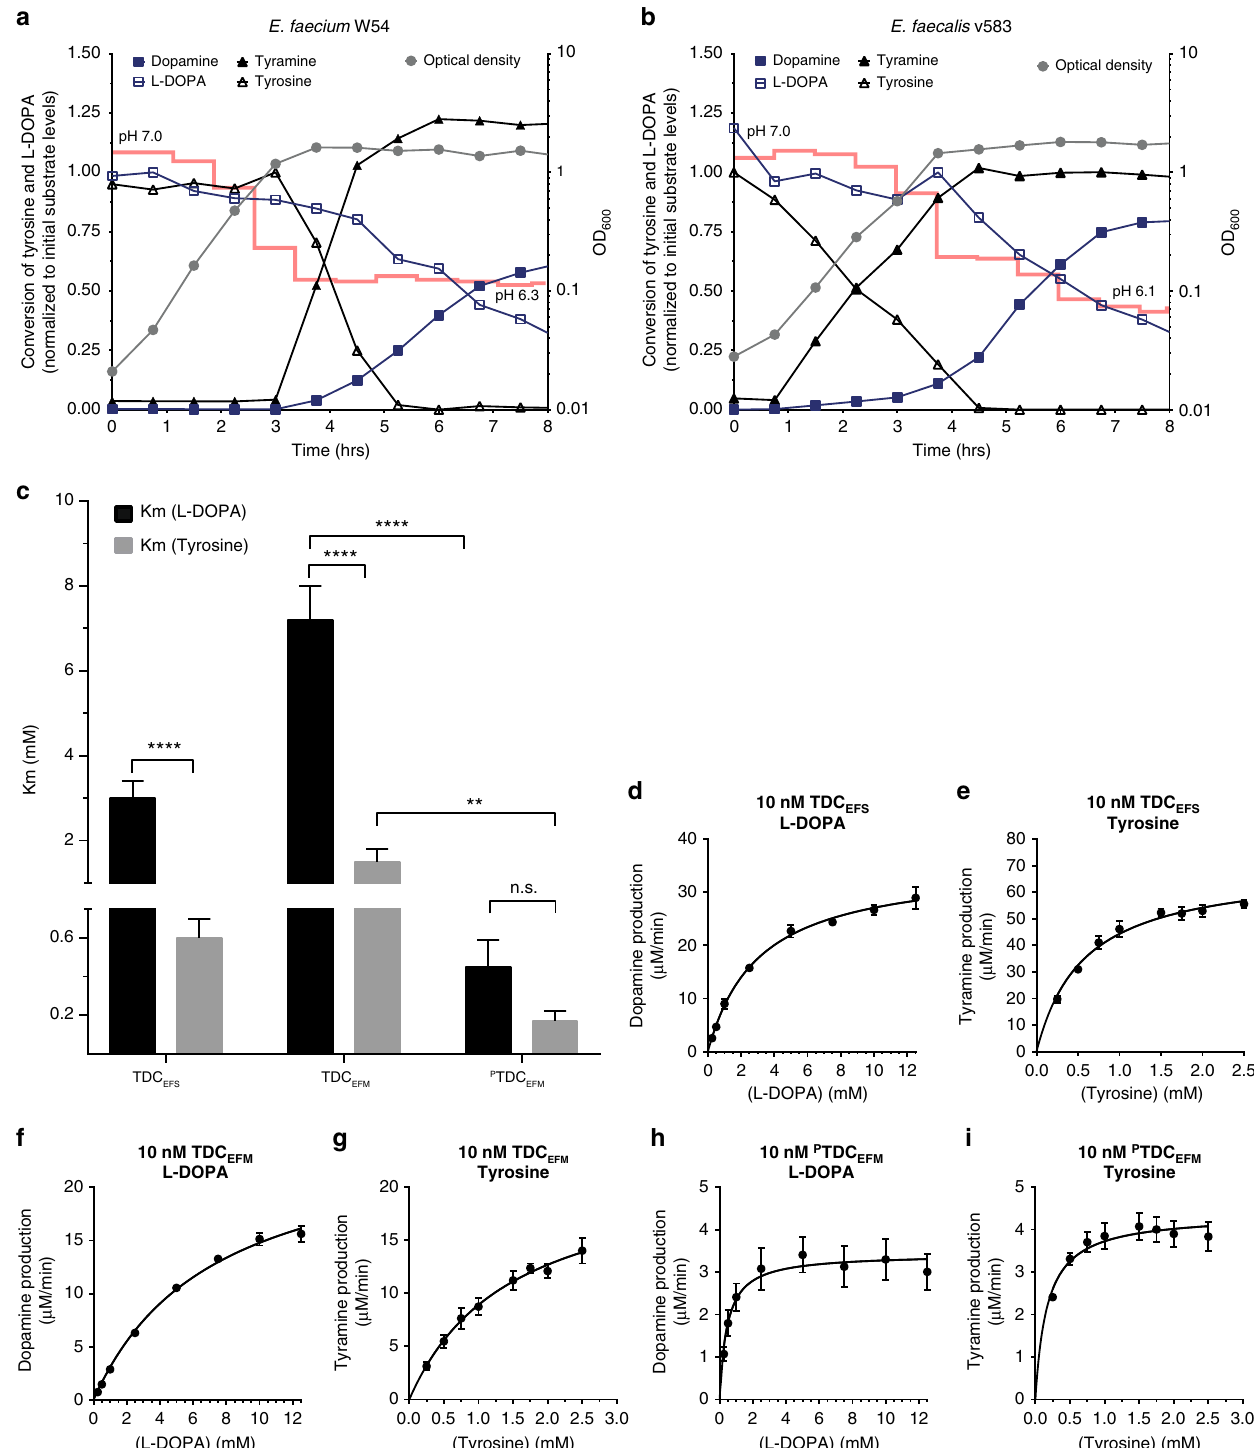
Fig. 3 Enterococci decarboxylate levodopa in presence of tyrosine despite higher af fi nity for tyrosine in vitro. Growth curve (gray circle, right Y -axis) of E. faecium W54 ( a ) and E. faecalis ( b ) plotted together with levodopa (open square), dopamine (closed square), tyrosine (open triangle), and tyramine (closed triangle) levels (left Y -axis). Concentrations of product and substrate were normalized to the initial levels of the corresponding substrate (100 µ M supplemented levodopa and ~500 µ M tyrosine present in the medium). pH of the culture is indicated over time as a red line. c Substrate af fi nity (Km) for levodopa and tyrosine for puri fi ed tyrosine decarboxylases from E. faecalis v583 (TDC EFS ), E. faecium W54 (TDC EFM , P TDC EFM ). d – i Michaelis – Menten kinetic curves for levodopa and tyrosine as substrate for TDC EFS ( d , e ), TDC EFM ( f , g ), and P TDC EFM ( h , i ). Reactions were performed in triplicate using levodopa concentrations ranging from 0.5 to 12.5 mM and tyrosine concentrations ranging from 0.25 to 2.5 mM. The enzyme kinetic parameters were calculated using nonlinear Michaelis – Menten regression model. Error bars represent the SEM and signi fi cance was tested using 2-way-Anova, Fisher LSD test, (* p < 0.02; ** p < 0.01; ****<0.0001) NATURE COMMUNICATIONS| (2019) 10:310